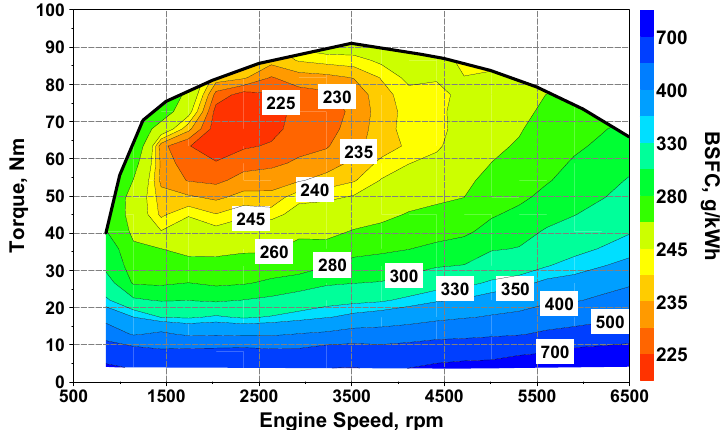
Figure 2. Engine BSFC map, g/kWh.